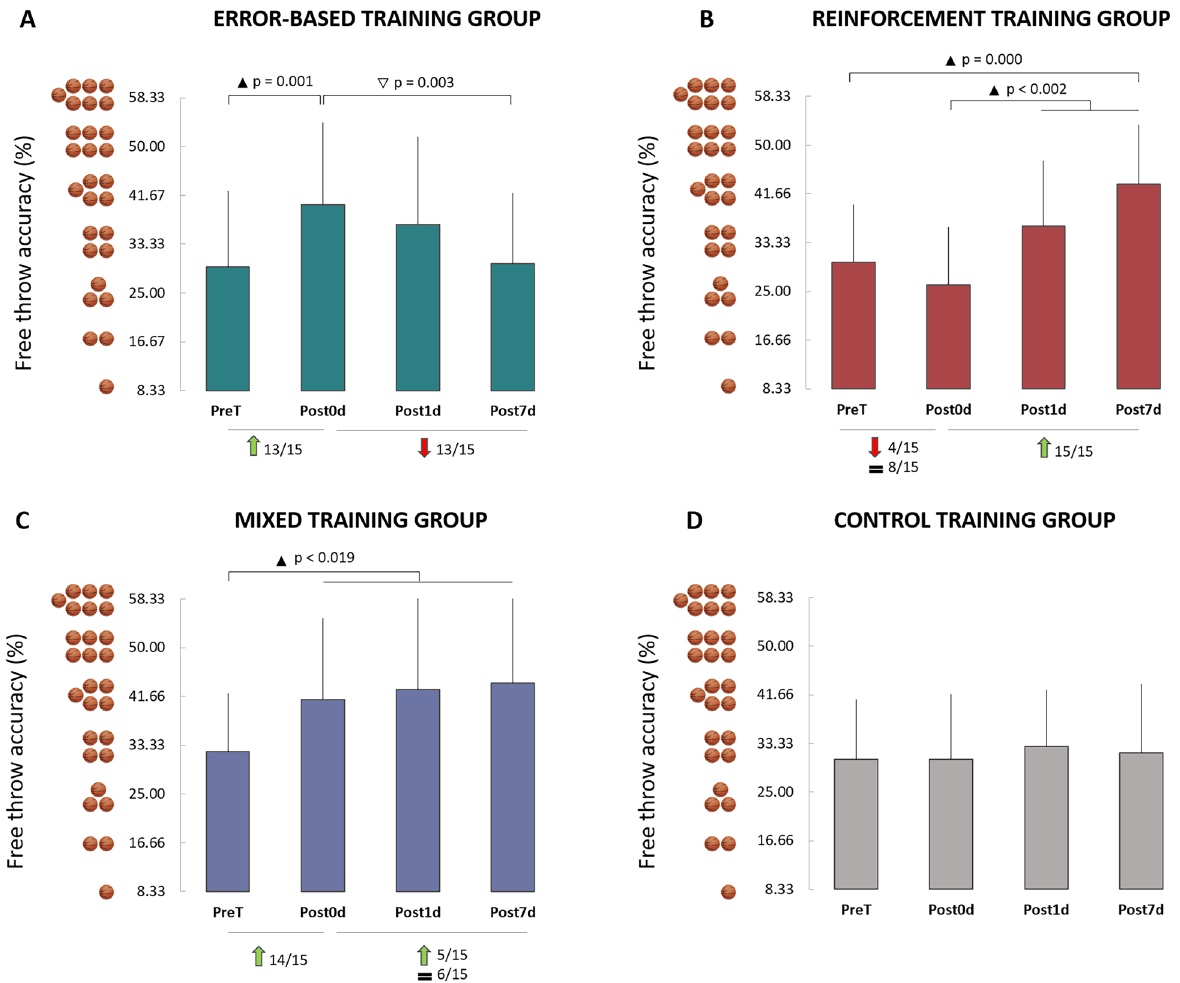
Figure 2. Average values (+ SD) of the free throw accuracy (%) for the four groups and the four tests. ( A ) Error- Based group. ( B ) Reinforcement group. ( C ) Mixed group. ( D ) Control group. Black triangles indicate significant improvement between tests, while the white triangle indicates significant deterioration. Green arrows, Red arrows, and the symbol ‘equal’ (=) indicate the number of participants who improved, decreased, or stabilized their freer throw accuracy, respectively. The basketballs near the vertical axis indicate the number of successful free